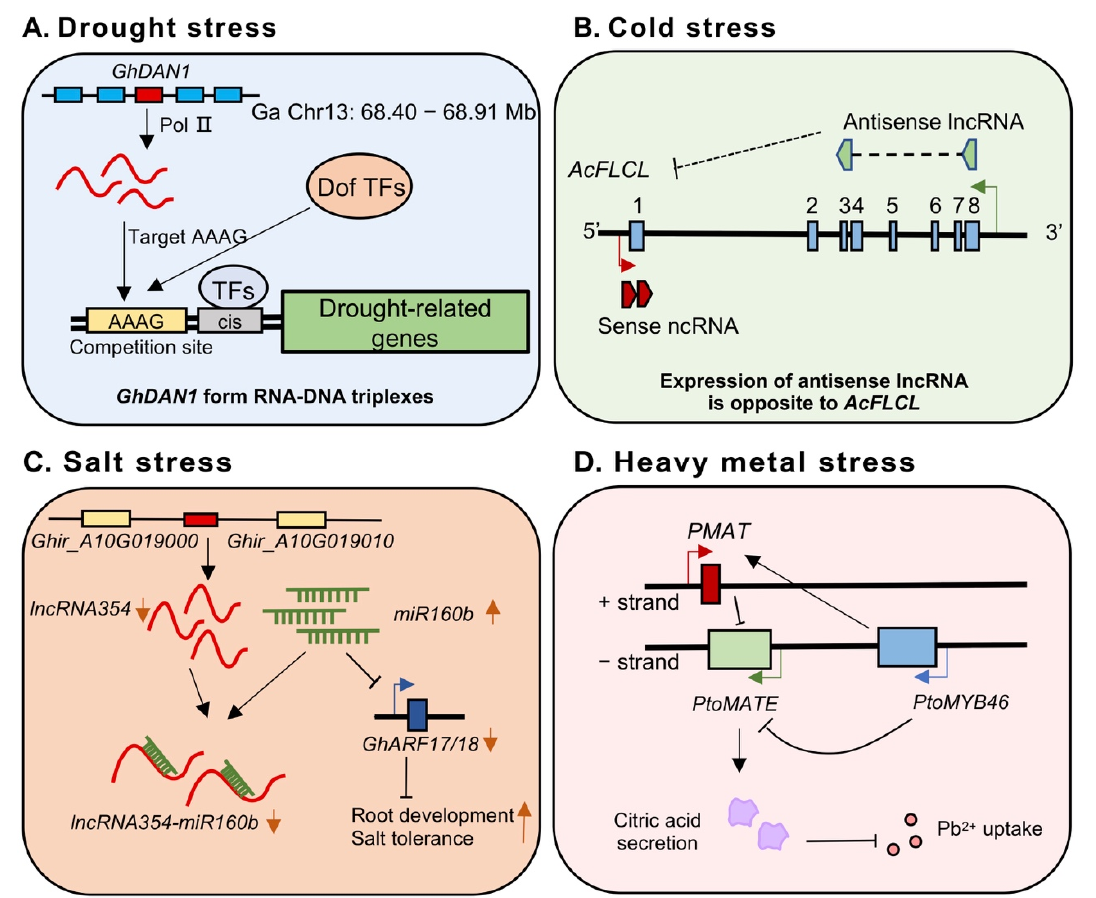
Figure 3. Representative examples of how plant lncRNAs respond to various abiotic stresses. ( A ) GhDAN1 in cotton, which is probably transcribed by Pol II, binds to an AAAG-rich DNA motif (corresponding to the core binding site of Dof TFs), forming the RNA-DNA triple. Drought stress reduced GhDAN1 expression, thus releasing the AAAG motif site of the drought-related genes to adapt to environmental drought stress. ( B ) An antisense long non-coding RNA confined to the distal end of the AcFLCL locus was found in kiwifruit, showing an opposite expression pattern to AcFLCL under cold stress. The black dashed line indicates that the regulatory pathway requires further verification. ( C ) The expression of LncRNA354 in upland cotton, which is located between Ghir_A10G019000 and Ghir_A10G019010 , is decreased under salt stress, thus impairing the binding to miR160b . Therefore, up-regulating the accumulation of mir160b, and inhibiting the expression level of GhARF17/18 to enhance salt stress tolerance. The arrows in orange represent the expression changes. ( D ) In poplar, LncRNA PMAT interacts with PtoMYB46 to inhibit the expression of PtoMATE under Pb 2+ stress. The downregulation of PtoMATE decreased the secretion of citric acid and increased the absorption of Pb 2+ . The black arrows denote positive effects, whereas lines ending with a short bar indicate negative